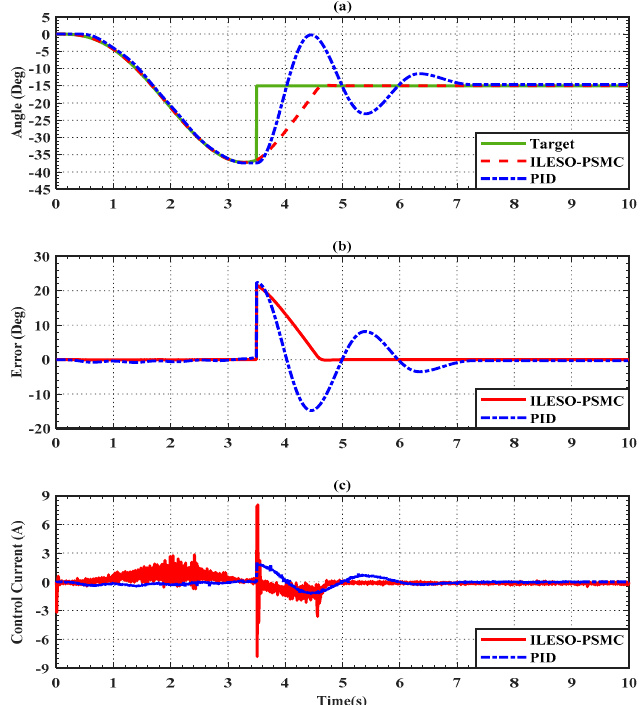
Figure 17. Discontinuity recovery safety test using PID and ILESO − PSMC. ( a ) Joint angle tracking response; ( b ) joint angle tracking error; ( c ) current control signal.